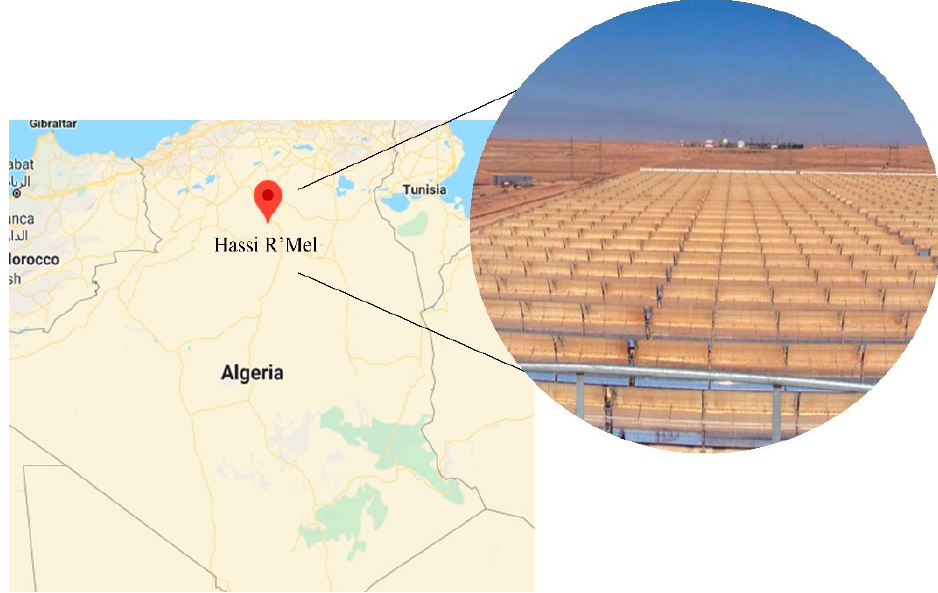
Figure 19. CSP Hassi R’mel station (Source: edited from Google Maps).